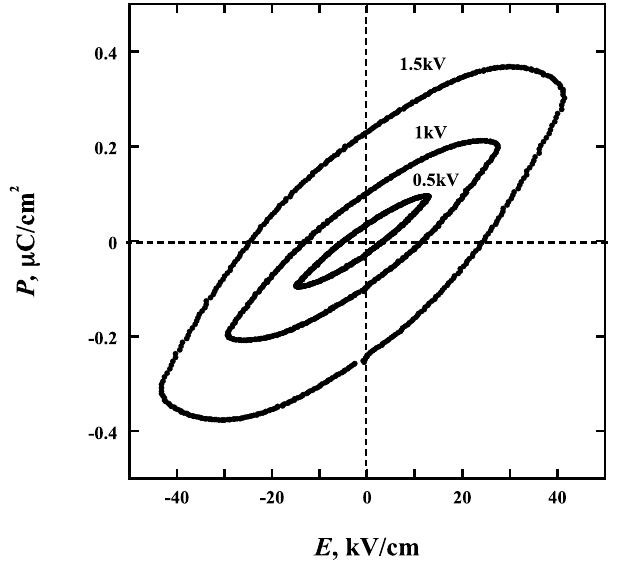
Figure 15. P-E hysteresis loop of KN4617: K from [51]. Copyright 2012